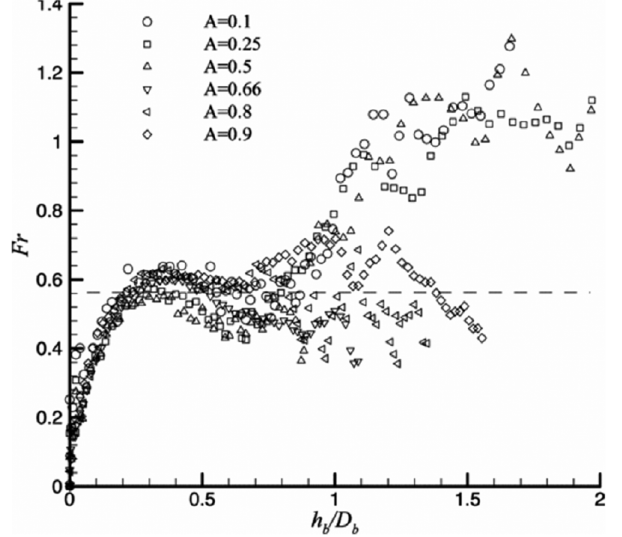
Figure 13. Froude number vs. h b /D b from 3D single-mode numerical simulations using the FLASH code [24].